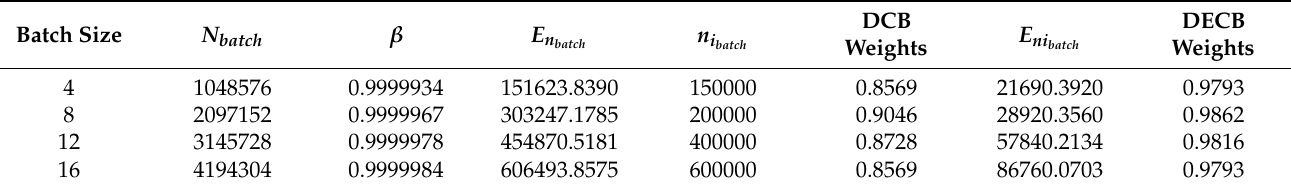
Table 2. Examples of DECB weighting method (512 × 512 size image).